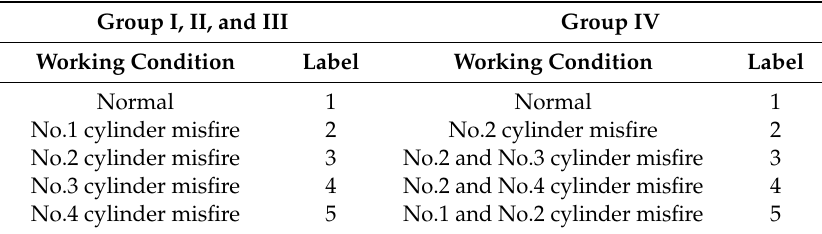
Table 5. Label lists of working